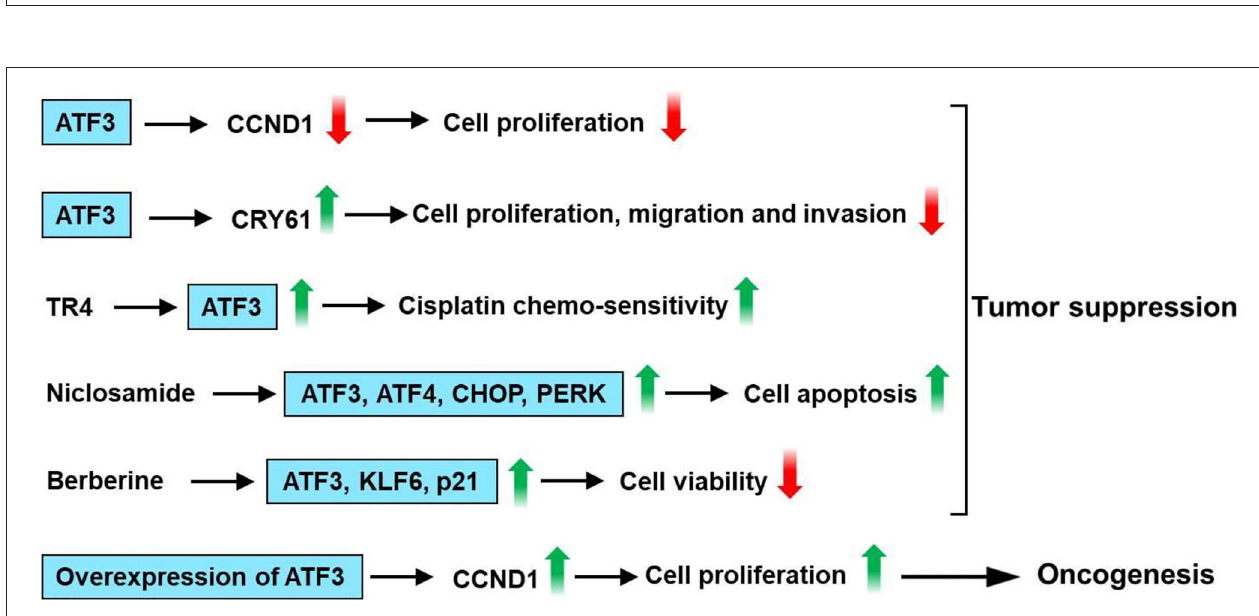
FIGURE 8 | ATF3 plays a vital role in liver cancer. Overexpression of ATF3 downregulates cyclin D1 expression in HepG2 cells. Cysteine-rich angiogenic inducer 61 (CYR61) is involved in the inhibitory effect of ATF3 on HCC cells. Knockdown of CYR61 significantly reversed ATF3-induced suppression of cell proliferation, migratory and invasive abilities in HCC cells. ATF3 is involved in testicular receptor 4 (TR4) upregulation of the cisplatin chemo-sensitivity in HCC cells. Niclosamide upregulates ATF3, ATF4, CHOP, and PRKR-like endoplasmic reticulum kinase (PERK) expression in HCC cells. ATF3 knockdown HCC cells had higher cell viability than control cells after niclosamide treatment. Berberine (BBR) suppresses proliferation and migration as well as induces cell cycle arrest and apoptosis in HCC cells. Furthermore, BBR upregulates protein expression of tumor suppressor genes, including KLF6, ATF3, and p21. These observations suggest that ATF3 acts as a tumor suppressor for liver cancer. However, overexpression of ATF3 increases cyclin D1 mRNA expression in the Hepa 1–6 mouse hepatoma cells. These observations show that ATF3 plays a dual role in liver cancer.